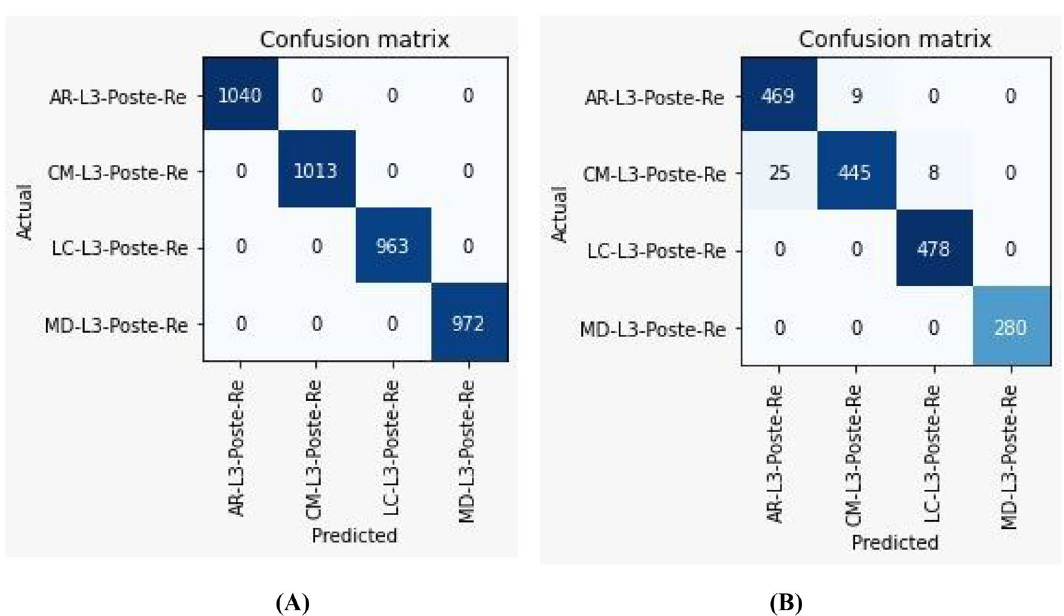
Figure 5. The confusion matrix achieved by the AlexNet model: ( A ) Validation ( B ) Test